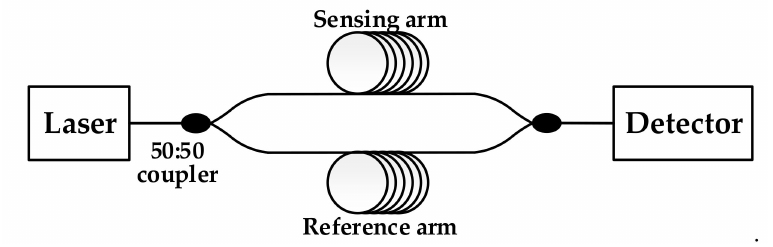
Figure 1. Configuration of fiber-optic Mach–Zehnder interferometer